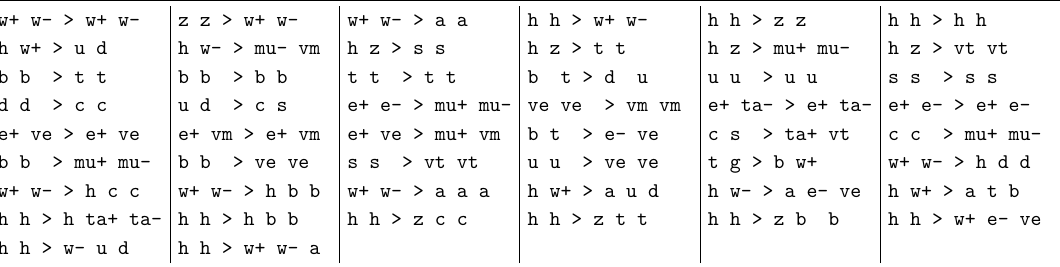
Table 33 . Set of processes that have been used to validate linearized propagator corrections implemented in the UFO models.